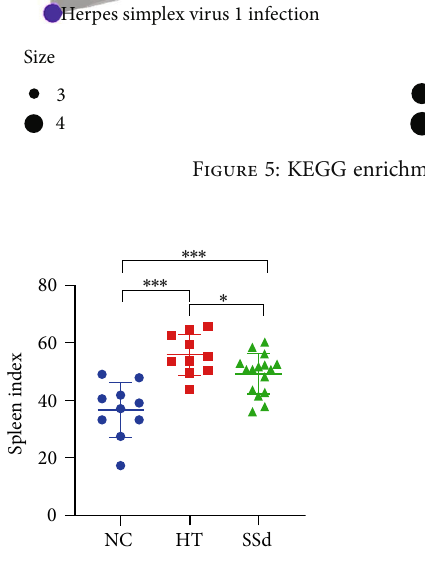
Figure 6: Mice spleen index ( ∗∗∗ P < 0 : 001 , ∗ P < 0 : 05 ).